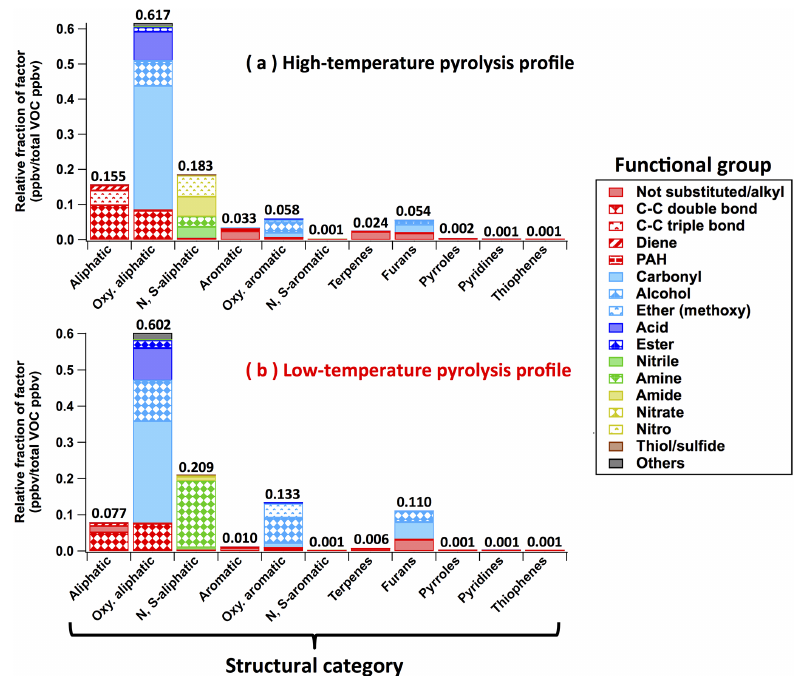
Figure 7. VOC composition in (a) high-temperature pyrolysis and (b) low-temperature pyrolysis emission profiles (Fig. 3) sorted by 11 structural categories and 17 functional groups. Some VOCs have multiple structures. These are counted once in each relevant category. For example, benzofuran is counted in the structural categories of “Oxy. aromatic” and “Furans” as “Not substituted/alkyl” functional group. Structures detected with low abundance (<0.002ppbv per total VOC ppbv) are mostly not-substituted or